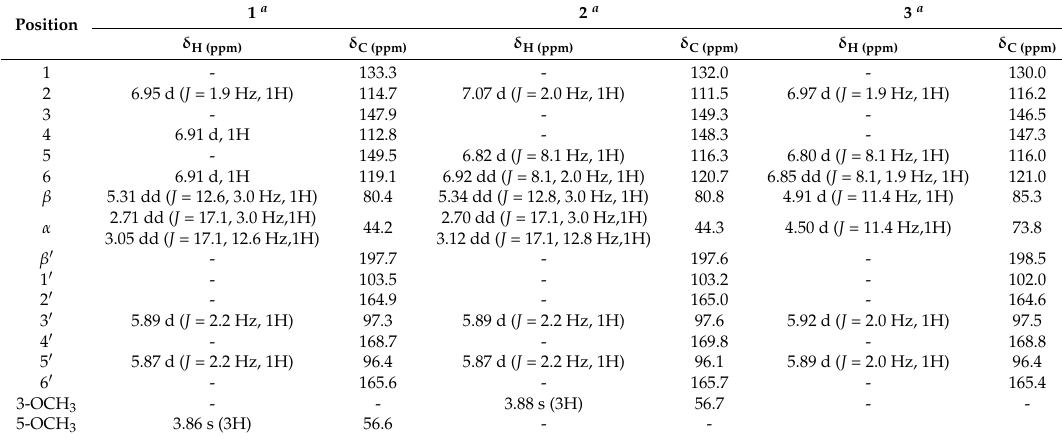
Table 1. 1 H and 13 C NMR spectroscopic data of compounds 1 – 3